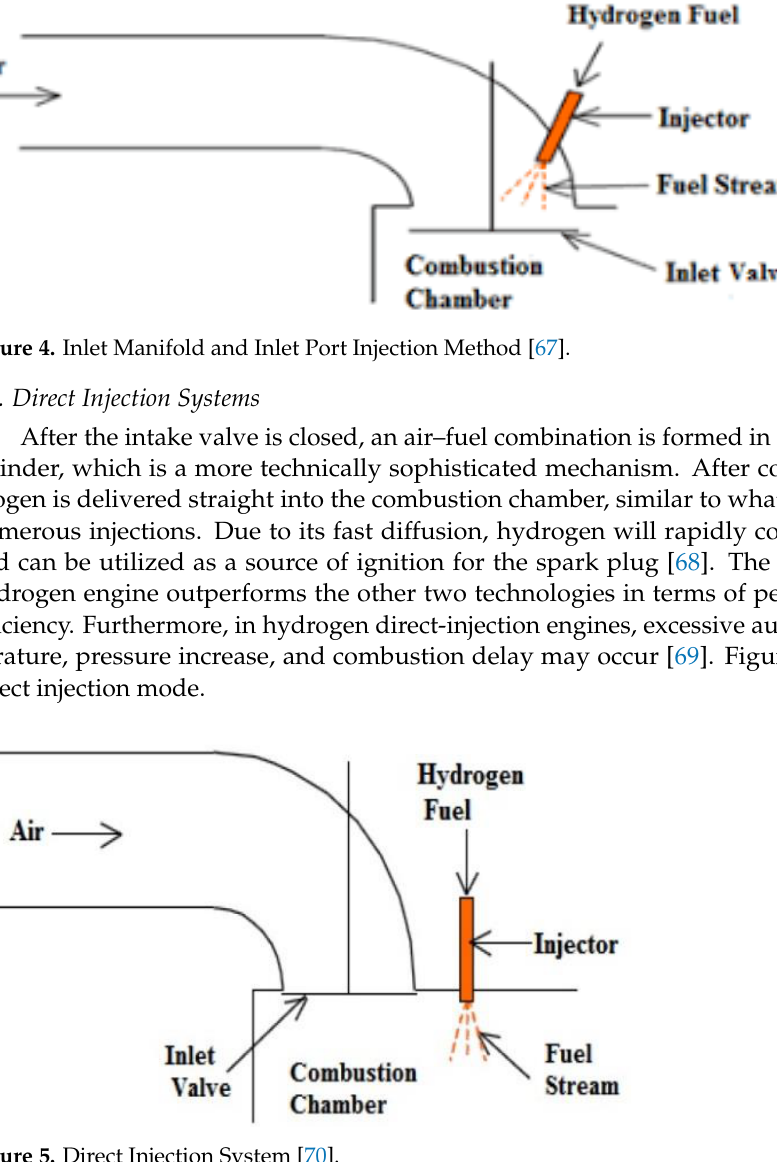
Figure 5. Direct Injection System [70].